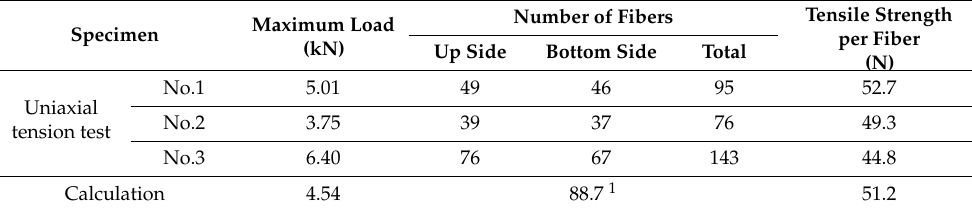
Figure 16. Uniaxial tension test specimen after loading (bottom side). Table 3. Uniaxial tension test results.